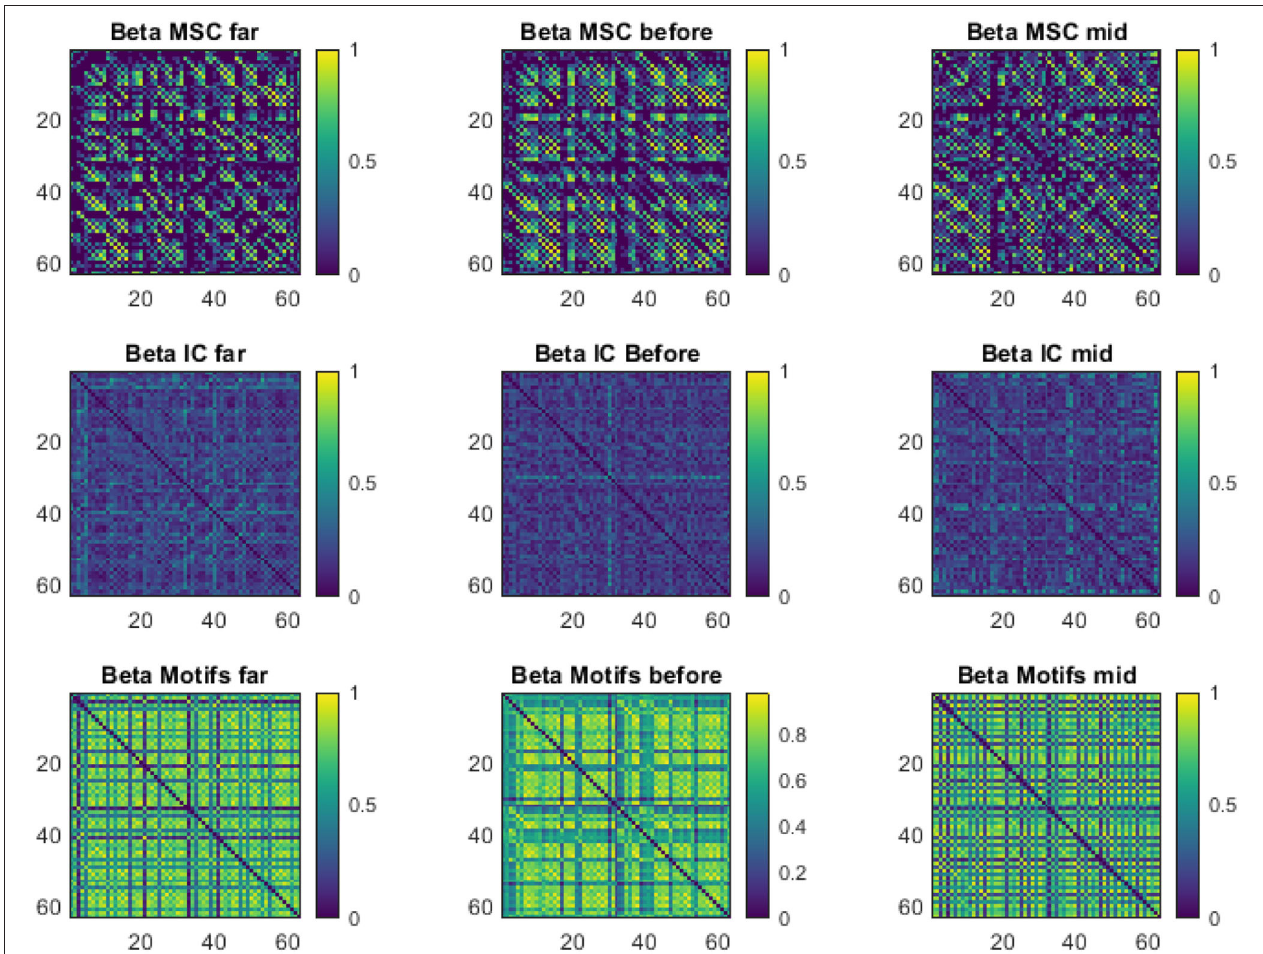
(strength: Figure 7 , cluster coefficient: Figure 8 , betweenness centrality: Figure 9 , eigenvector centrality: Figure 10 , and efficiency: Figure 11 ) for the motifs technique in the beta